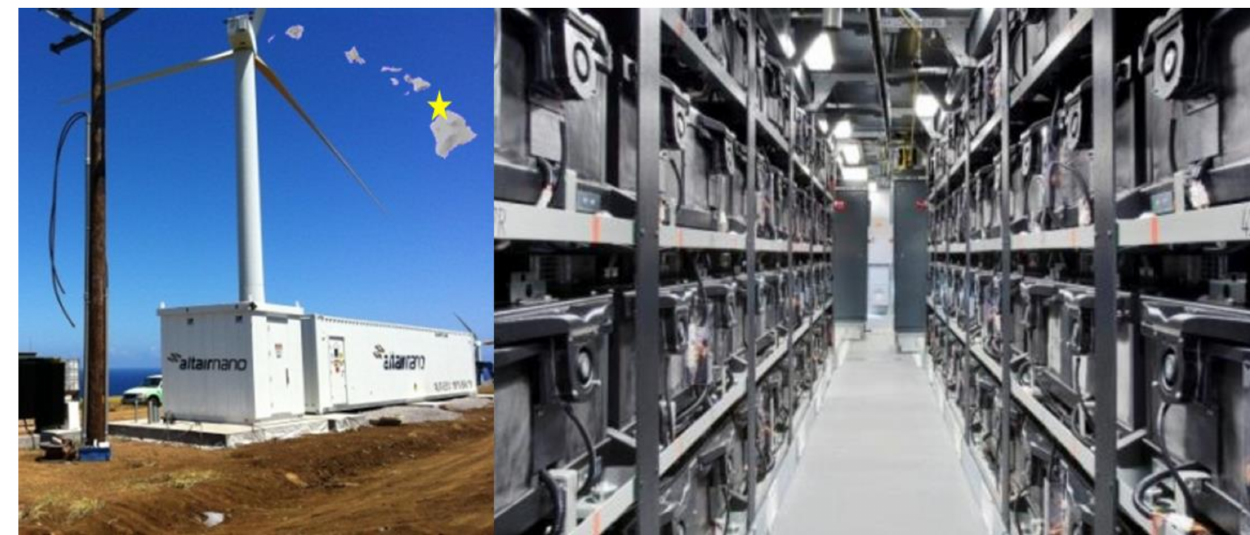
Figure 1. Outside and inside view of the